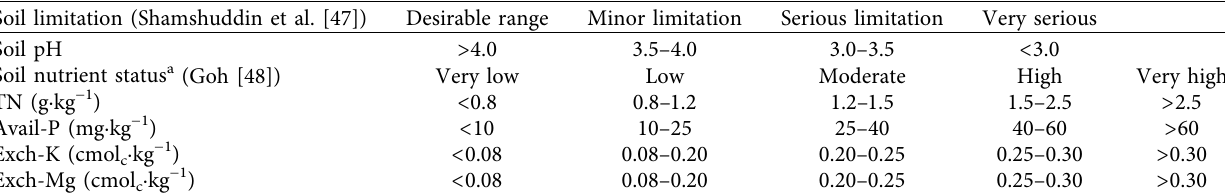
Table 4: Soil suitability evaluation for oil